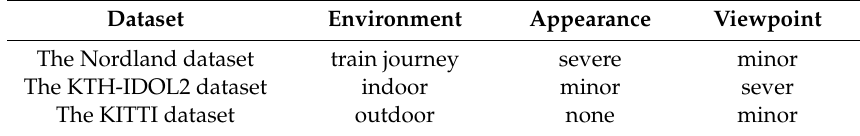
Table 1. The dataset used in our experiment and show the change in appearance and